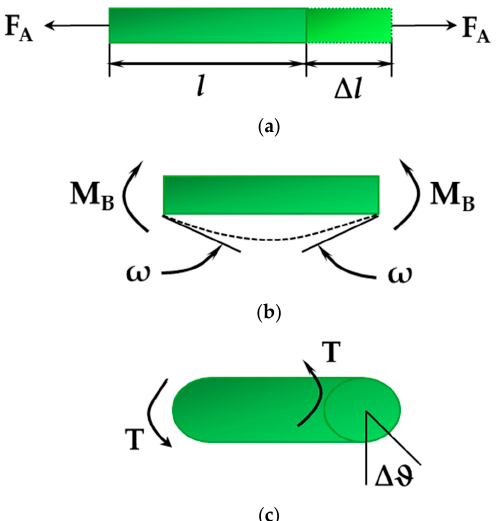
Figure 5. Beam deformation modes: ( a ) pure tension; ( b ) pure bending; ( c ) pure torsion.